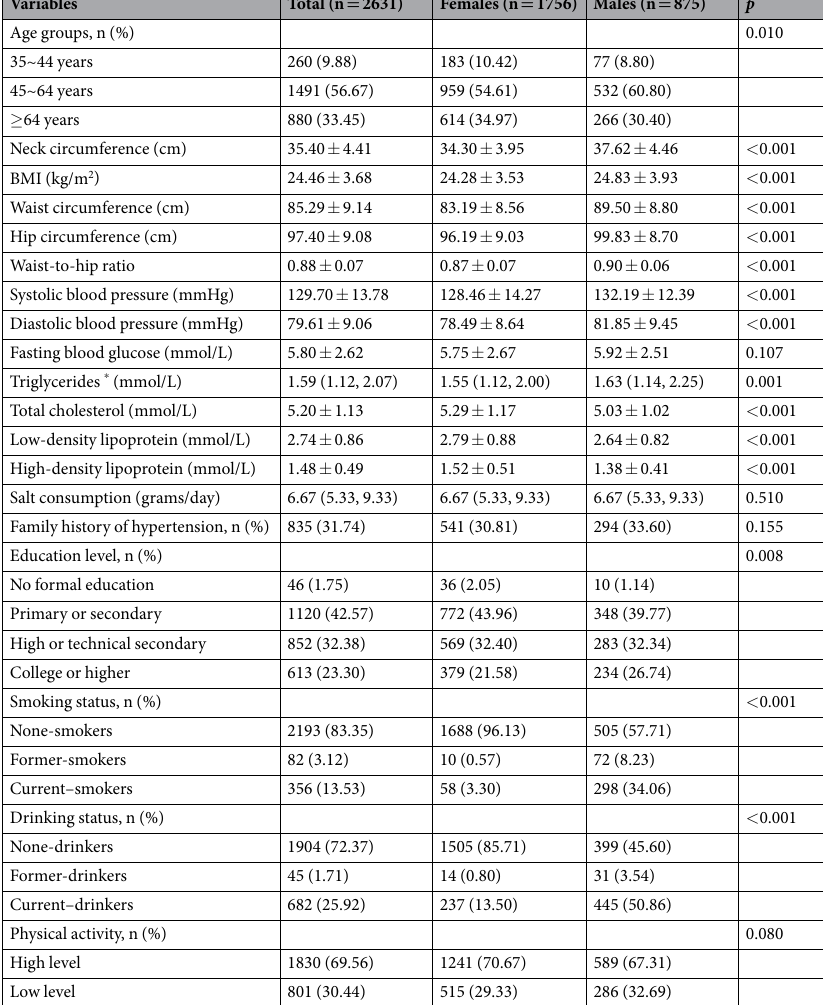
Table 1. Baseline characteristics of the study subjects by gender. p - value < 0.05 was considered statistically